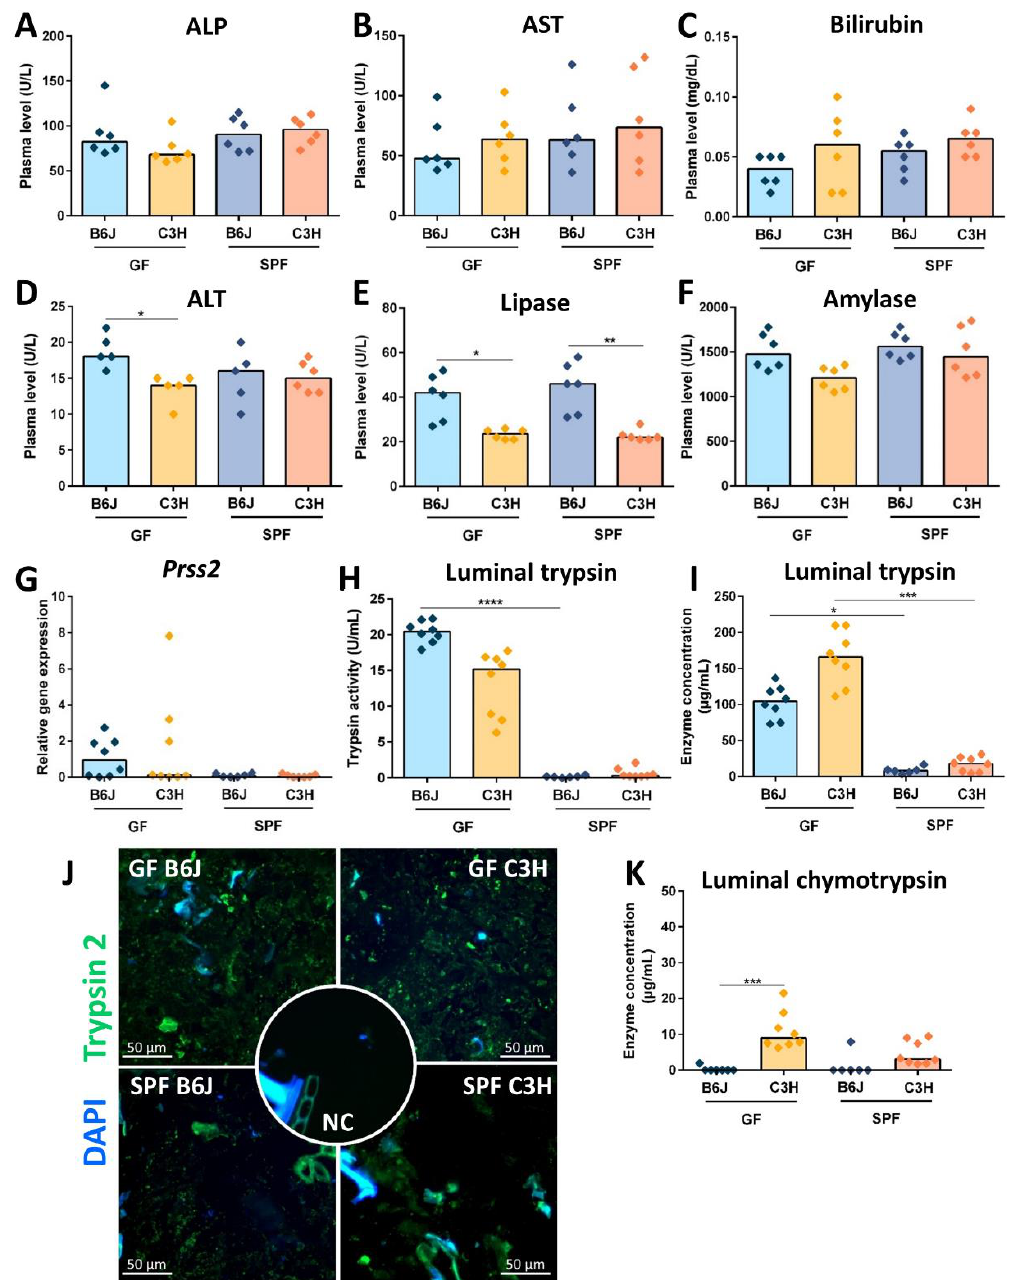
Figure 6. Contribution of digestion enzymes to the cecal enlargement. ( A – D ) Liver enzymes: ( A ) alkaline phosphatase (ALP), ( B) aspartate aminotransferase (AST), ( C ) bilirubin, and ( D ) alanine aminotransferase (ALT) determined in plasma of GF and complex microbiota colonized B6J and C3H mice (n = 6). Kruskal-Wallis test with Dunn´s multiple comparison test * p < 0.05. Box plot indicates median. Each symbol represents one independent sample. ( E – G ) Pancreatic digestive enzymes: ( E ) pancreatic lipase, ( F ) pancreatic amylase determined by routine clinical chemistry methods in plasma of GF and complex microbiota colonized B6J and C3H mice (n = 6). Kruskal-Wallis test with Dunn´s multiple comparison test ** p < 0.001, * p < 0.05. Box plot indicates median. Each symbol represents one independent sample. ( G ) Gene expression of Prss2 measured by qPCR in total RNA isolated from the pancreas of GF and complex-microbiota colonized B6J and C3H mice. Relative differences in gene expression were calculated by the comparative 2 − ∆∆ Ct method. Kruskal-Wallis test with Dunn ´ s multiple comparison test. Box plot indicates median. Each symbol represents one independent sample. ( H – K ) Luminal levels of digestive enzymes: ( H ) Luminal trypsin activity of GF and complex microbiota colonized B6J and C3H mice measured by ELISA. Kruskal-